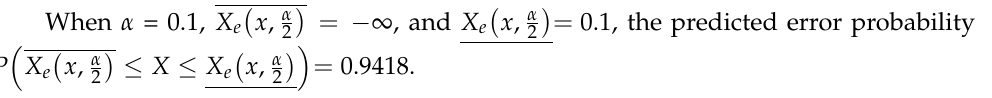
Figure 14. Distribution of fitted prediction error probability density function.